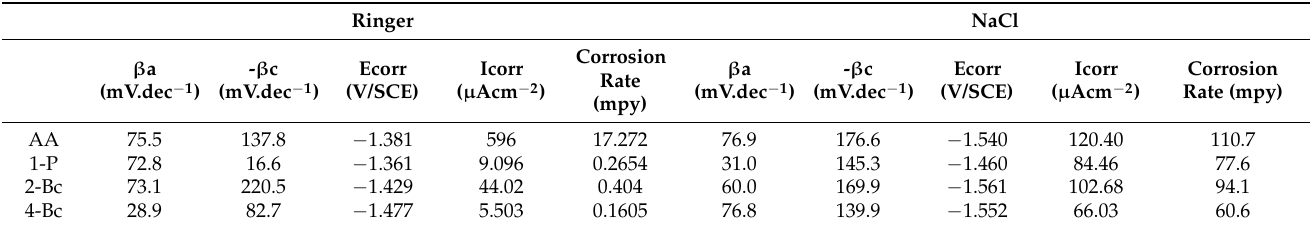
Table 2. Electrochemical parameters obtained from potentiodynamic polarization curves of the AA and ECAPed ZK30 Mg alloys in ringer lactate and 3.5%